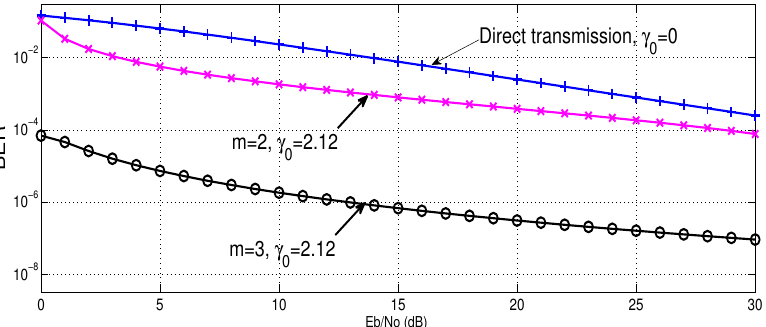
Figure 4. BER comparison of incremental relaying with cooperative retransmissions, using m = 2 and m = 3, with direct